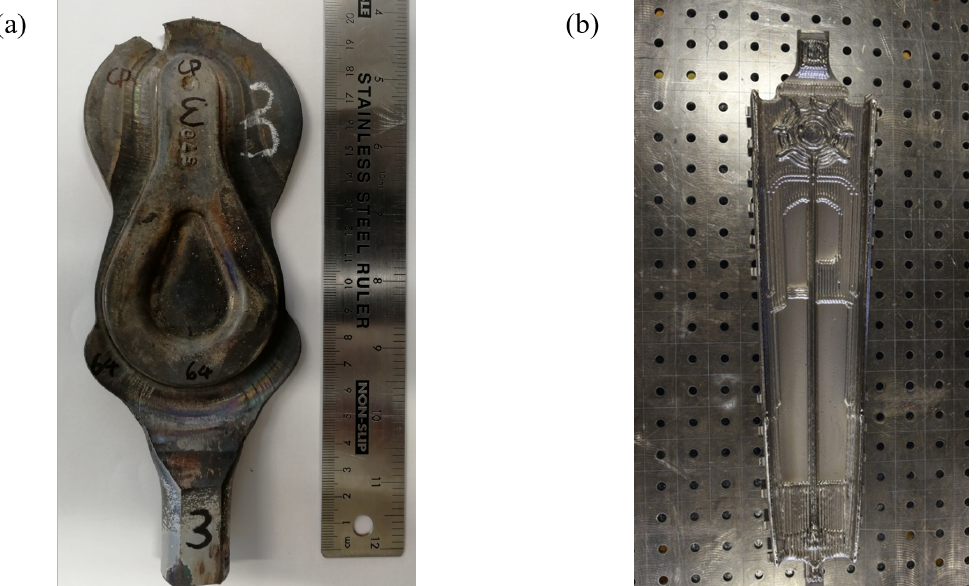
Figure 8. Titanium components manufactured by hybrid processing routes: ( a ) eye-bolt manufactured at the W.H. Tildesley, Wolverhampton and the University of Sheffield by the FAST- forge process; and ( b ) airframe structure manufactured by the Arconic Ampliforge TM hybrid AM-forging process. The image in ( b ) reproduced with permission from Arconic